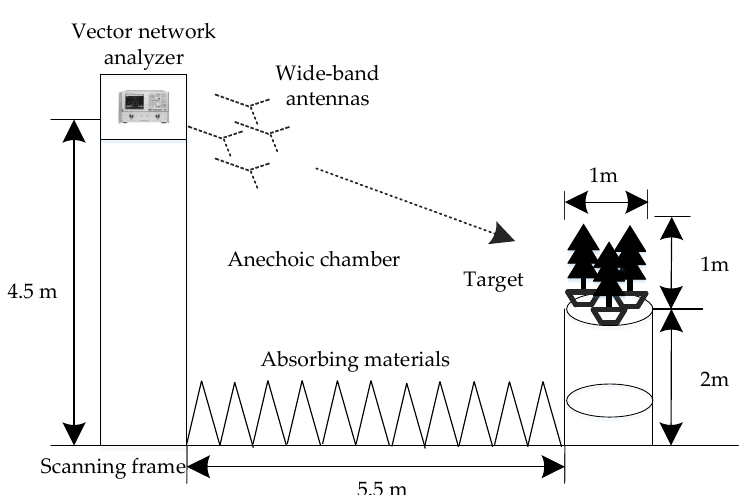
( b ) Figure 11. Relationship between the MSE of amplitude for each channel and SNRs and sparse samples. ( a ) SNRs; and ( b ) sparsely sampling percentage of full data. 4.2.2. Real Measured Data in the Anechoic Chamber Experimental results are presented with the usage of real data acquired in the anechoic chamber to demonstrate the validity of the proposed method. As shown in Figure 12, the PolSAR hardware- in-the-loop system consists of a scanning frame, a vector network analyzer, four wideband antennas, and the scene including three trees. The movement of the scanning frame along a slide guide simulates the flight trajectory of airborne SAR. During the data acquisition, four antennas are employed with two transmitting horizontal (H) and vertical (V) polarization waves, and the other two receiving H and V polarization returns, which is shown in Figure 13a. It should be noted that due to the hardware limitation, the polarimetric measurement is not simultaneous, which means that the polarization waveform is alternately transmitted between H and V polarization, that is, first H